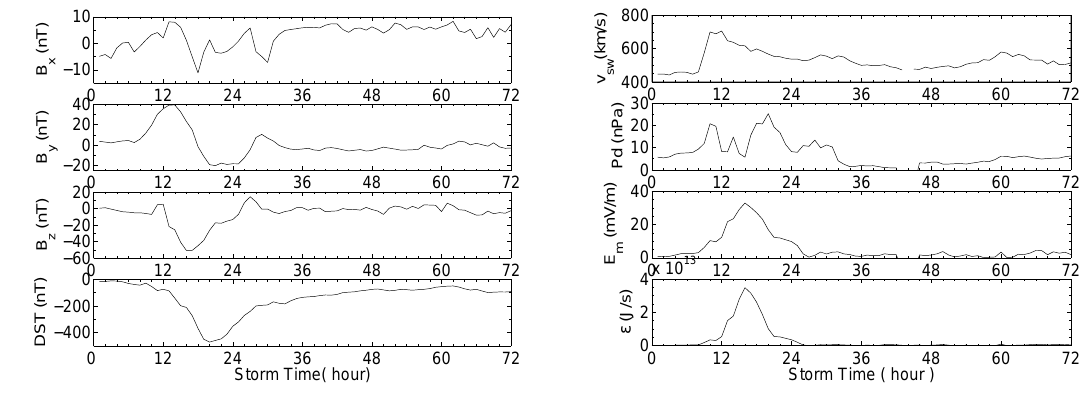
Fig. 6. Typical storm-time solar wind parameters, including IMF B x , B y , B z components in the GSM coordinate system, velocity, v sw , dynamic pressure, P d , merging electric field, E m , Akasofu parameter, ε , and D st variations on 20–22 November 2003.